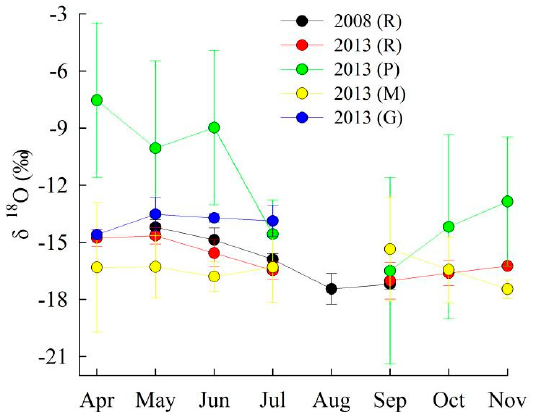
Figure 6. The levels of δ 18 O values in river water (R), in comparison to those in precipitation (P), meltwater (M) and groundwater (G) at the Hailuogou basin over two melt seasons in 2008 and 2013.